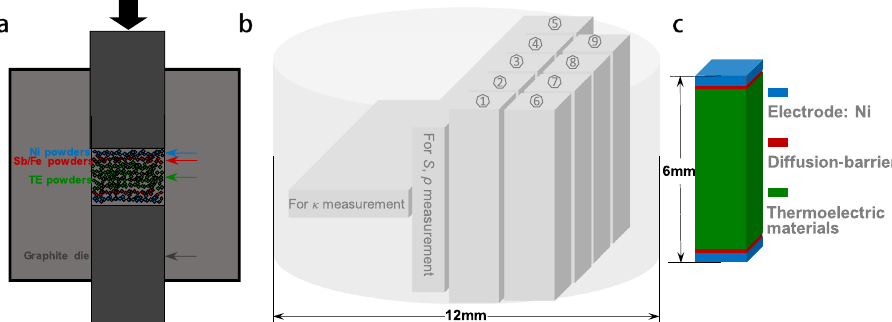
Fig. 2 Schematic of the tellurium-free legs fabricated. Schematic of the powder packing of the one-step hot-pressing ( a ), schematic slicing diagram of the cylinders ( b ), and schematic of a leg showing the contact structure ( c ).